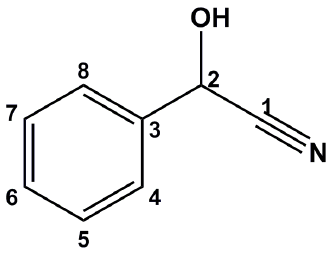
Figure 1. Structure of mandelonitrile.